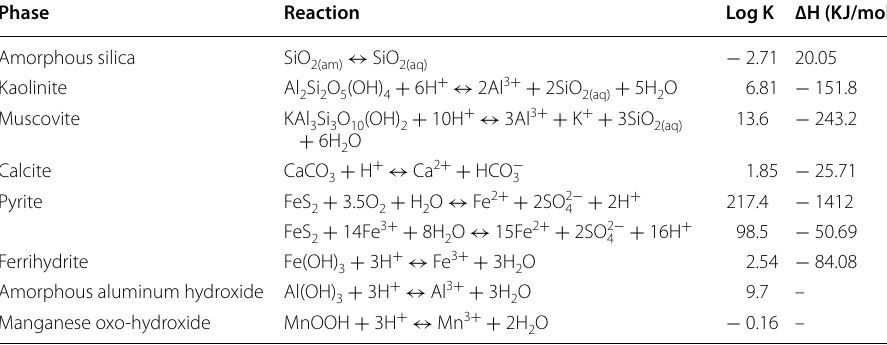
Data taken from the LLNL database, except log K of ferrihydrite (SIT database) and amorphous aluminum hydroxide (Kittrick 1969). Values for the standard enthalpy of formation ΔH for amorphous aluminum hydroxide and manganese oxohydroxide are not available in the databases